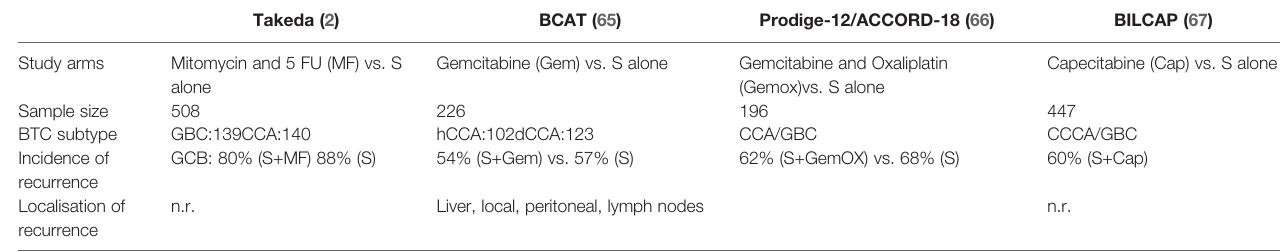
TABLE 1 | Phase III trials exploring the role of adjuvant